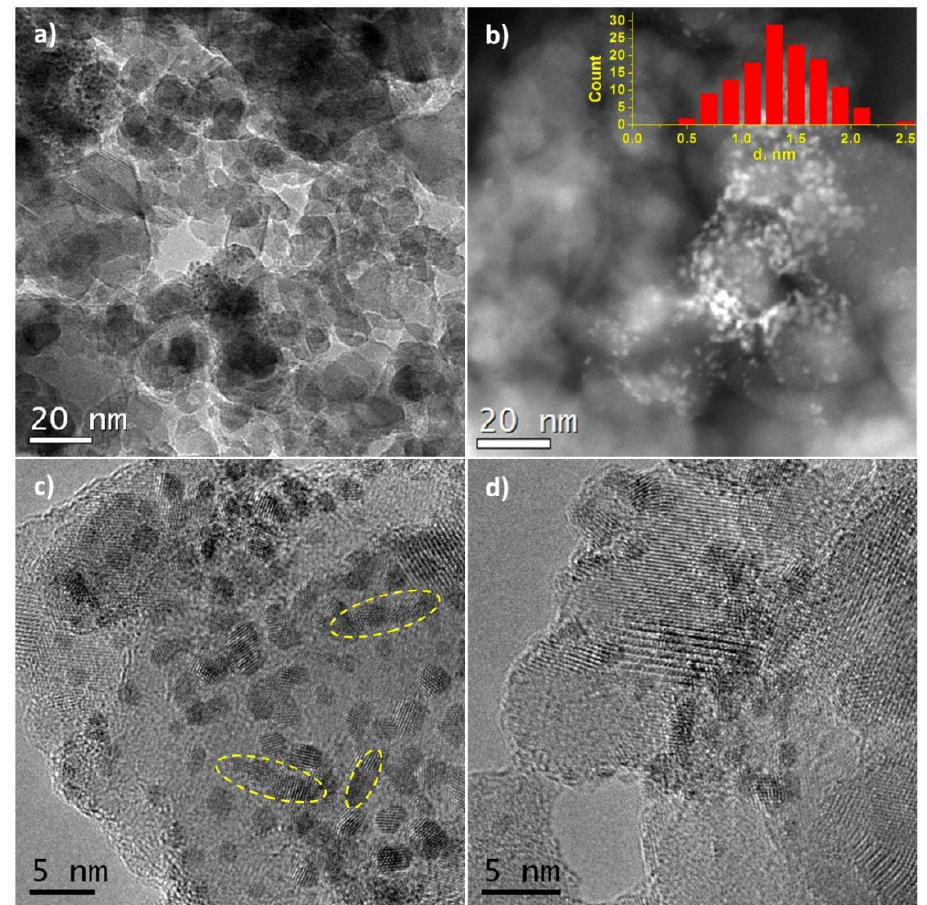
Figure 2. ( a,c,d ) High-resolution transmission electron microscopy (HRTEM) and ( b ) high-angle annular dark-field imaging scanning transmission electron microscopy (HAADF-STEM) images for Pt / Ti-PLA-400 sample. The inset shows the size distribution of platinum